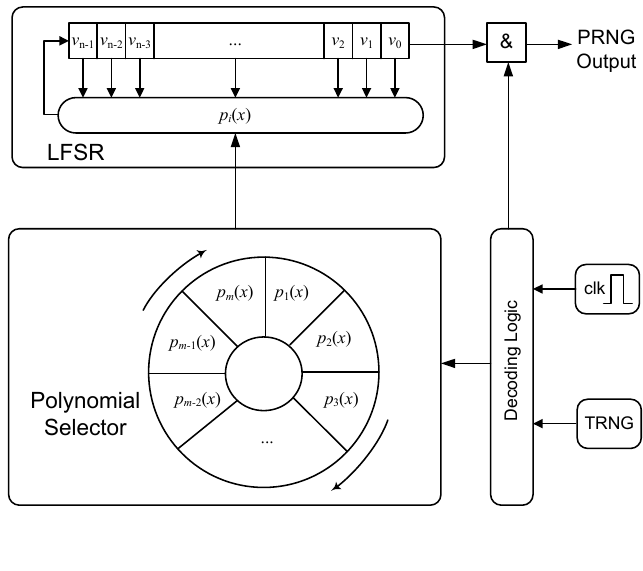
Figure 1. Block diagram of J3Gen. PRNG, pseudo-random number generator; LFSR, linear feedback shift